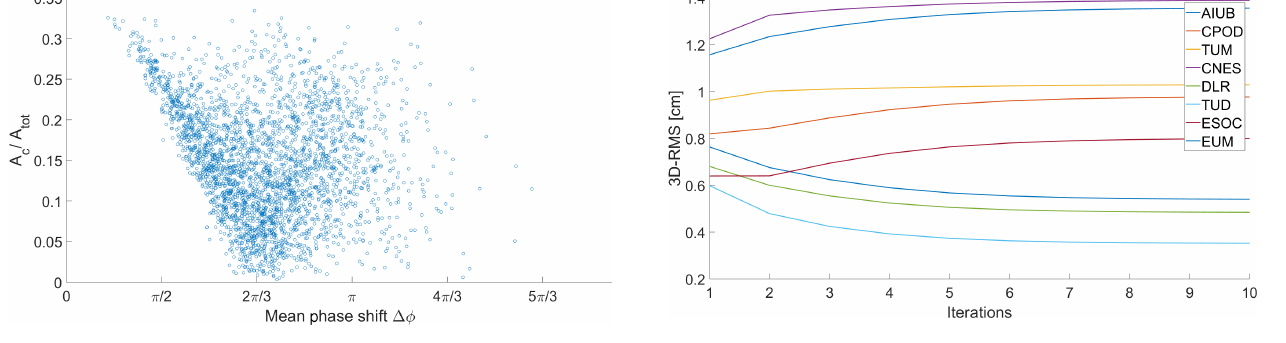
Figure 8. Simulations of combination of solutions affected by peri- odic noise.